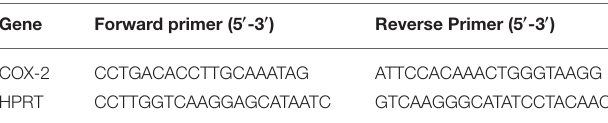
TABLE 1 | Primer sequences for the amplification of qRT-PCR products from canine FFPE tissue samples.